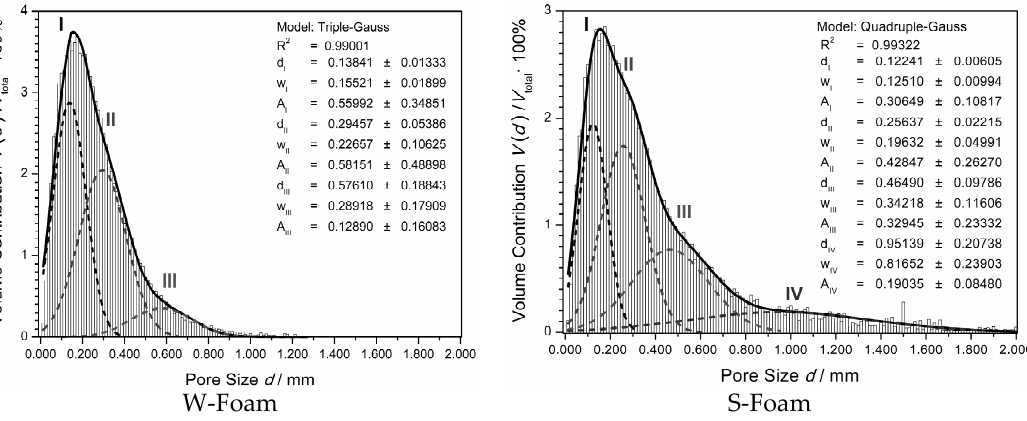
Figure 4. The volumetric pore size distribution for both the W- and S-foam. The volume contribution V ( d )/ V total of the pores of a given size to the VOI (BMP not resized, image pixel size 6.25 µm). Each bar graph shows the apparent pore size distribution, the overlaid thick solid line represents the sum of the overlapped peak-components (I–IV), and the dashed lines represent the distributions separated by Gaussian analysis.